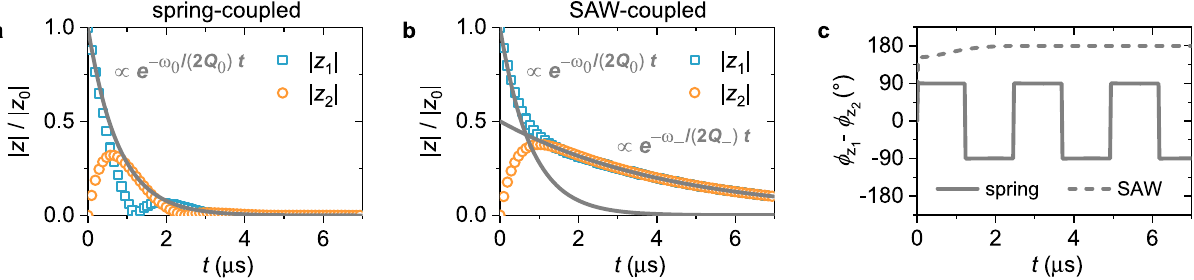
Fig. 4 Dynamics of two spring-coupled resonators in comparison to two pillar resonators coupled by surface acoustic waves (SAWs). The spring- coupled resonators are at the threshold of the strong coupling regime and the SAW-coupled pillar resonators are separated by d = 0.3 λ SAW /2. a Amplitudes of the two spring-coupled resonators and ( b ) the two SAW-coupled pillar resonators as a function of time t . A single spring-coupled resonator has the same eigenfrequency f 0 = 84.18 MHz and quality factor Q 0 = 208 as a single pillar resonator. The grey lines show the amplitude decay of a single pillar resonator and of two antisymmetrically vibrating pillar resonators separated by d = 0.3 λ SAW /2. In the latter case, the fi nite element method simulations discussed above gave f − = 84.27 MHz and Q − = 1145. In both graphs, we reduced the amount of data points for the sake of clarity. c Phase difference between the displacements of the two spring-coupled and the two SAW-coupled pillar resonators.